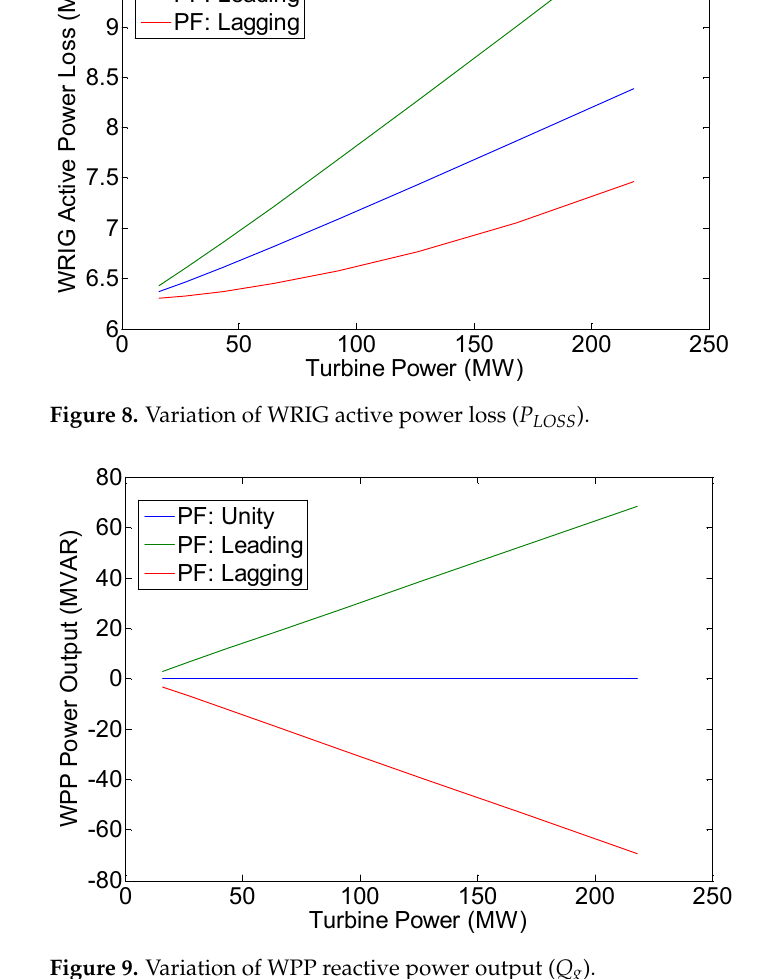
Figure 10. Variation of WRIG rotor power ( Q R ). Figure 11. Variation of WRIG reactive power loss ( Q LOSS ).